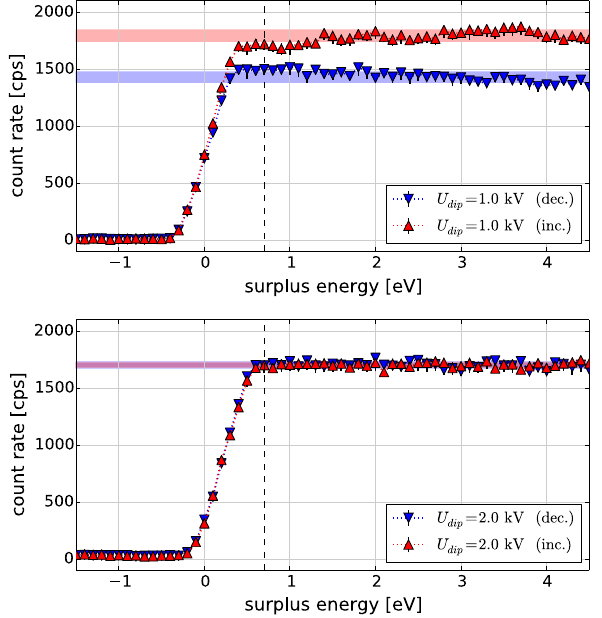
Fig. 6 Measured transmission functions at two different dipole volt- ages. If the dipole voltage is not sufficient to remove trapped electrons, a hysteresis effect is observed between measurements with decreasing ( inverted triangles ) or increasing ( upright triangles ) surplus energy. The horizontal bars indicate the nominal rate in each measurement. The nominal rate is computed as the average of the respective data points on the right side of the dashed line . The bar width indicates the standard deviation of the averaged data points. While at U dip = 1kV the hysteresis is clearly visible, it disappears completely at U dip =